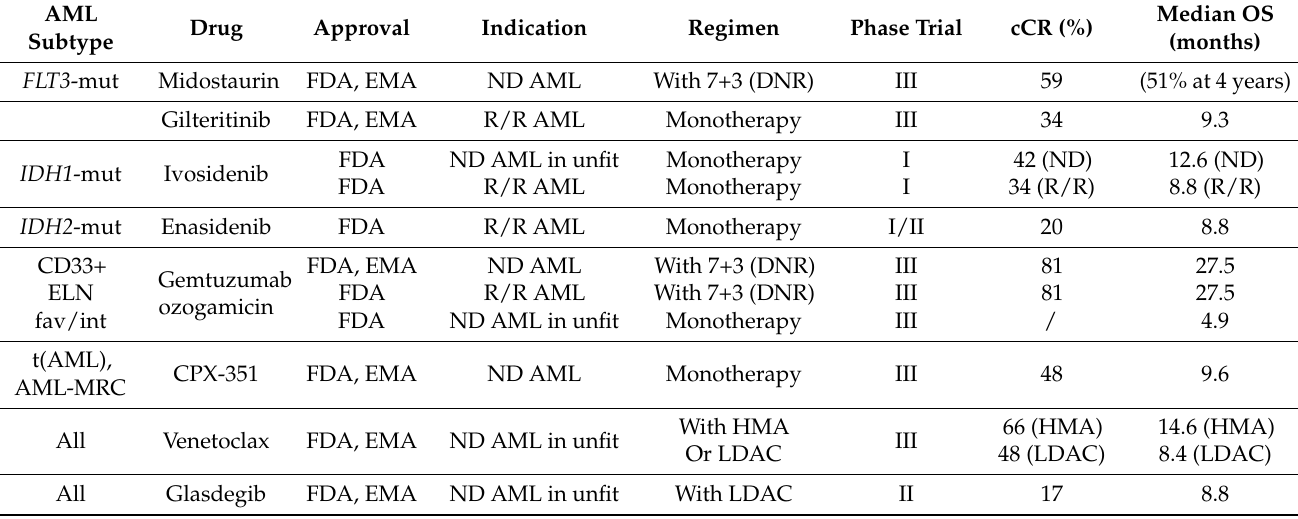
Table 4. Recently approved drugs for older AML